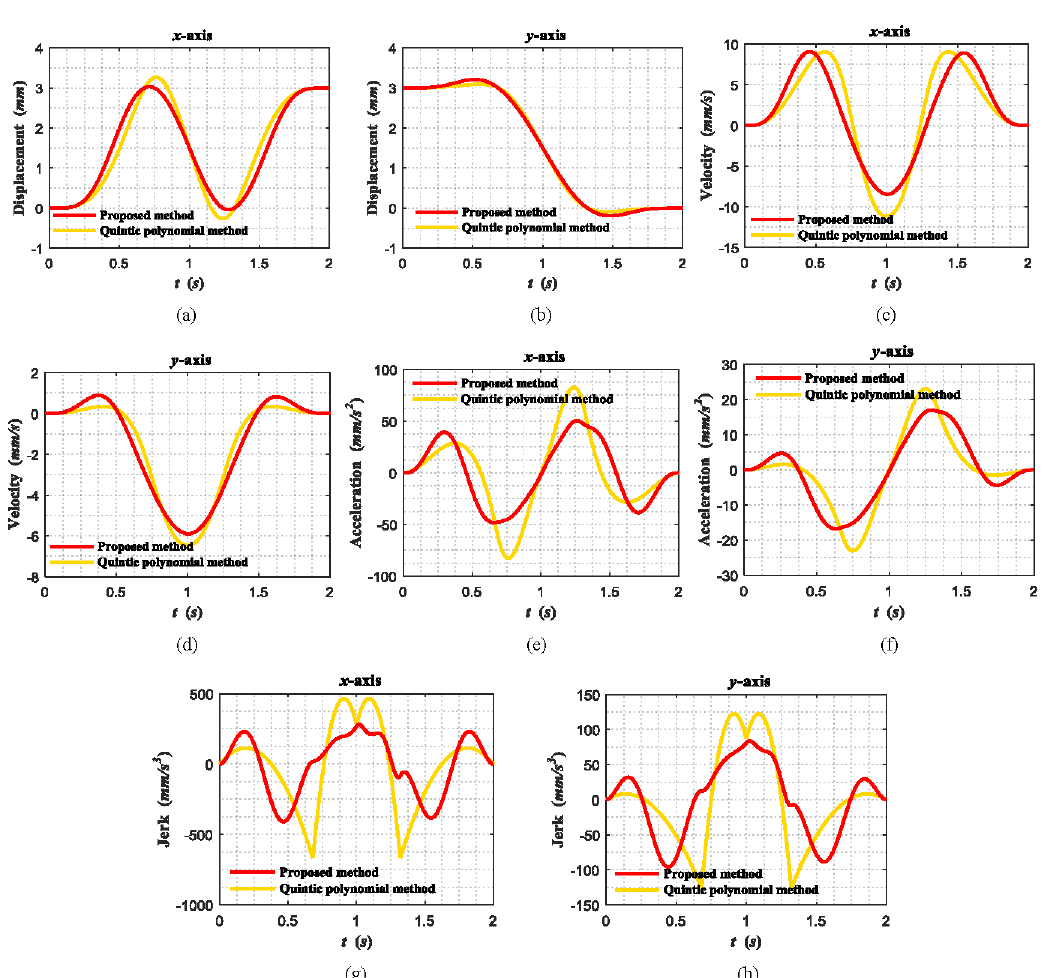
Figure 5. Comparison of kinematic profiles: (a) x -axis displacement profiles, (b) y -axis displacement profiles, (c) x -axis velocity profiles, (d) y -axis velocity profiles, (e) x -axis acceleration profiles, (f) y -axis acceleration profiles, (g) x -axis jerk profiles, and (h) y -axis jerk